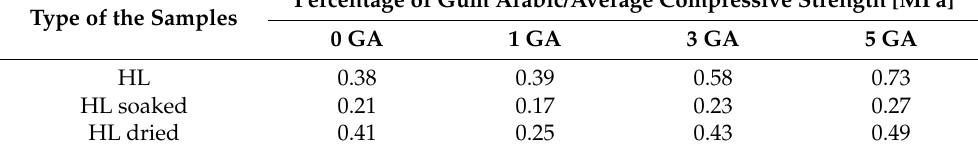
Table 6. Average values of the compressive strength of composites. Type of the